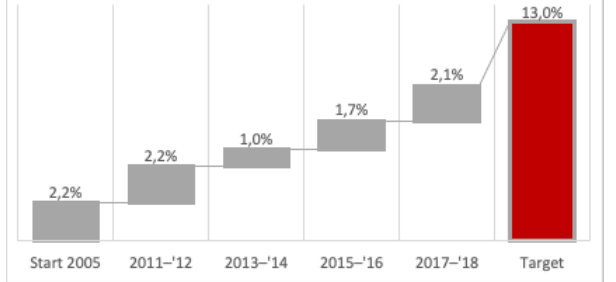
Figure 10. Belgium—energy consumption trend. Source: https://ec.europa.eu/eurostat/web/ energy/data/shares, accessed on 28 June 2021.